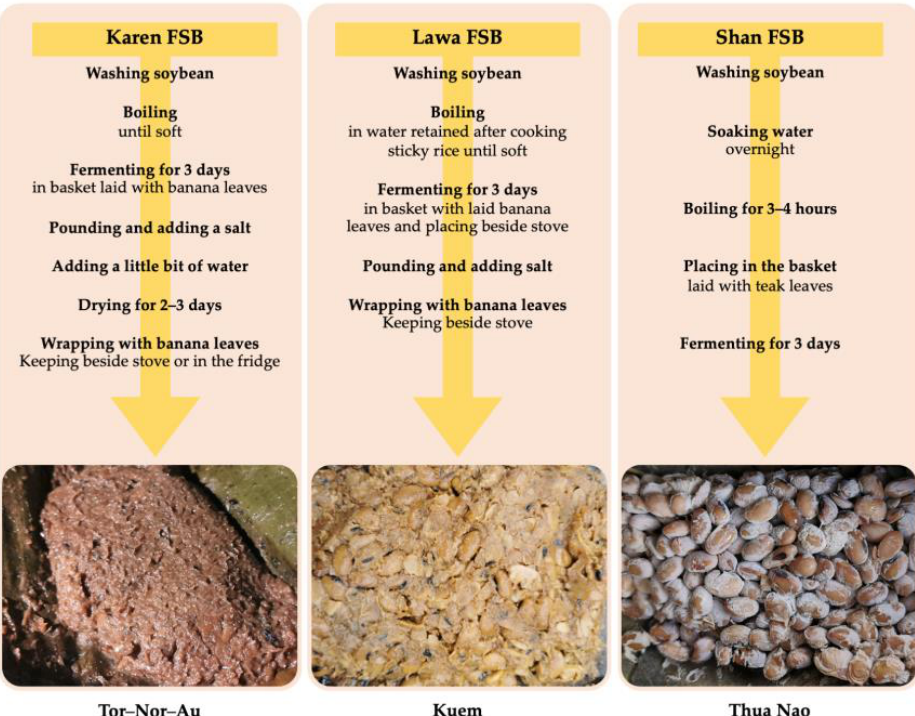
Figure 1. The appearance and production processes of fermented soybean products of three ethnic groups: Karen, Lawa, and Shan, which are known by their native languages as Tor-Nor-Au, Kuem, and Thua Nao, respectively.